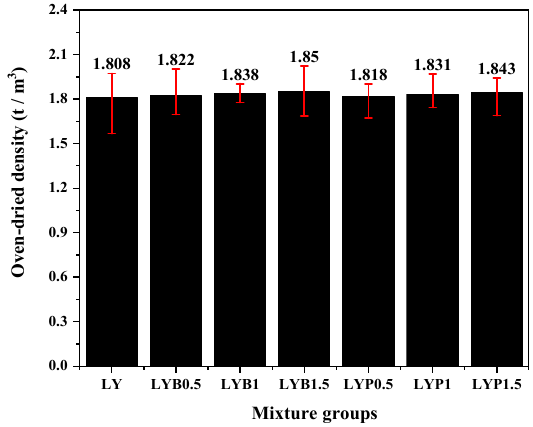
Figure 3. Oven-dried density of mixture groups.